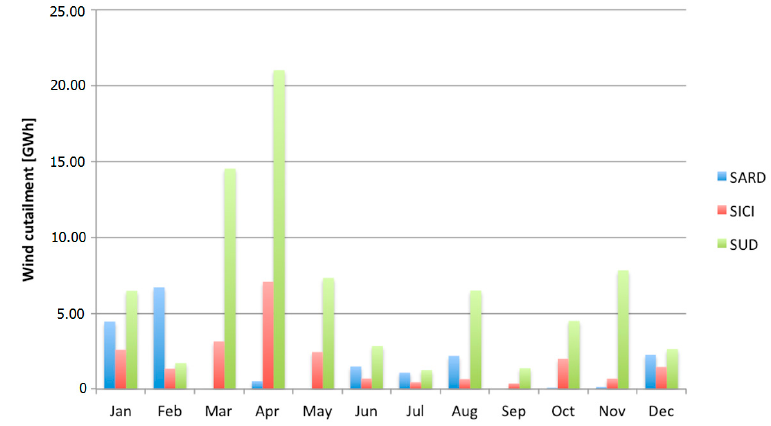
Figure 12. Monthly wind curtailment values in the zones SUD, SICI, and SARD, resulting from the simulation.